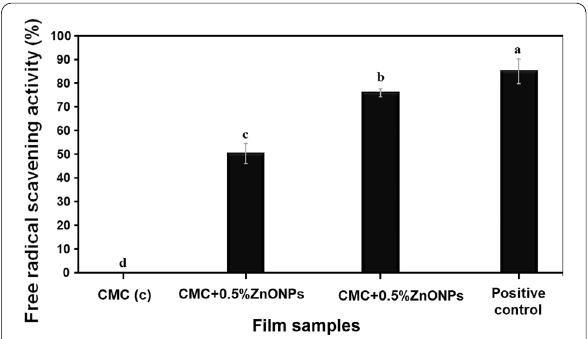
Fig. 6 DPPH free radical scavenging activity of the prepared films. Ascorbic acid was used as positive control. Calculated mean is for triplicate measurements from three independent experiments a − d means with different superscripts are considered statistically different (LSD test, P ≤